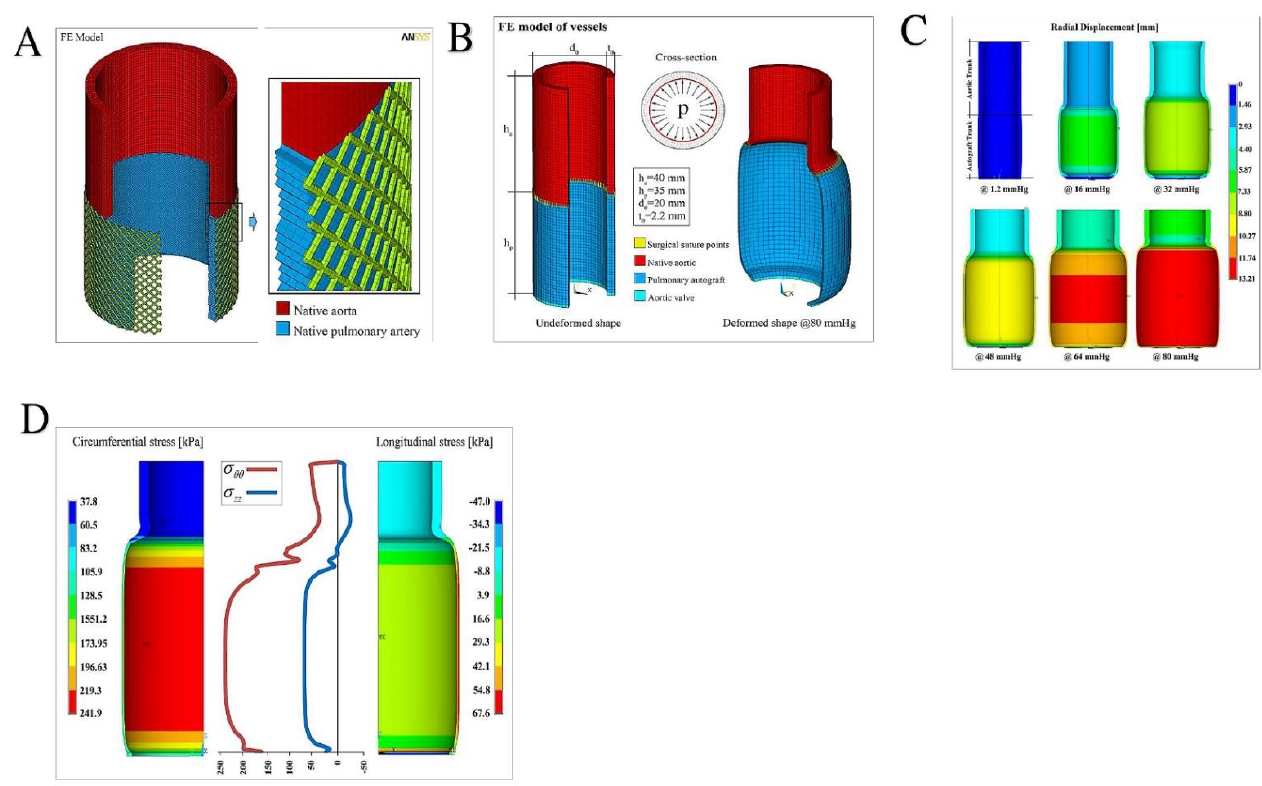
Figure 6. ( A ) Left: pulmonary autograft reinforced with semiresorbable prosthetics integrated in pulmonary autograft wall. Right: geometry of the FE model, with a detailed correlation of the native aorta (in red) and the pulmonary artery tract (blue), integrated with the external e-PTFE structure at the time of full development ( B ) Overall sketch of the Finite Element model reconstruction of the aorta-suture-autograft-annulus ensemble: undeformed system (left); deformed (at the maximum pressure level) model (right) and cross-section with applied pressure. At the bottom, the legend with the details of the elements used, distinguished for material properties. ( C ) Sequence of deformations at increasing pressure levels up to 80 mm Hg. The contour plots refer to the displacements along the radial direction (in mm). ( D ) Hoop (circumferential) and longitudinal (axial) stress profiles as a function of the vessel axis (middle), with contour plot details showing the spatially inhomogeneous distribution of the stresses (in kPa). Abbreviations; e-PTFE; expanded polytetrafluoroethylene.